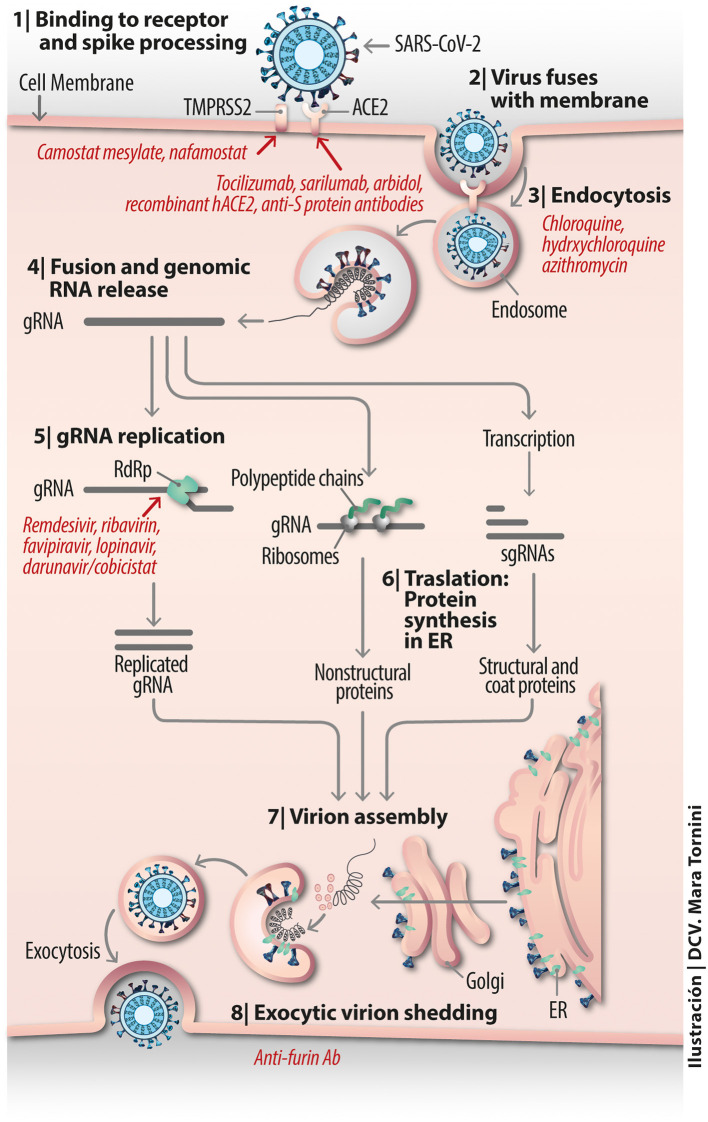
Vital cycle of SARS-CoV-2 from host cell receptor binding to exocytic virion shedding.